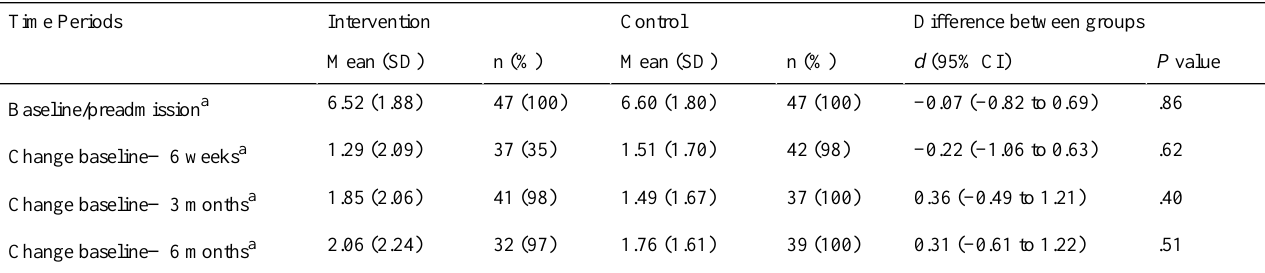
Table 4. Secondary outcome assessment self-efficacy for managing chronic disease score; per-protocol analysis.